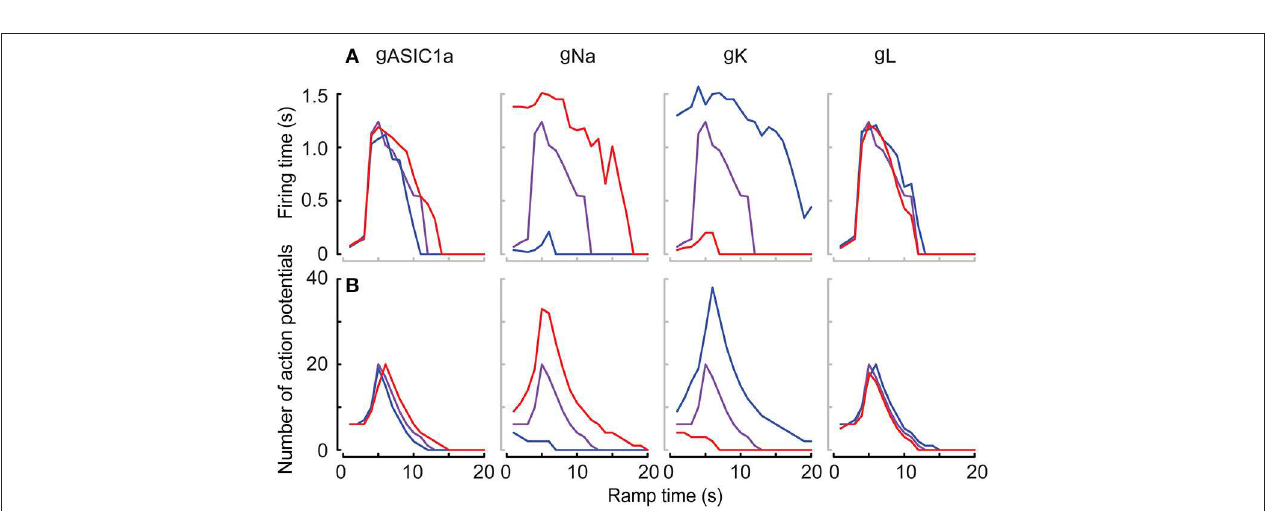
FIGURE 9 | Heat maps of the simulated neuronal activity as a function of the pH ramp lowest value and duration (RT) in seconds, for ramps starting at pH 7.4. Shown are the number of APs (A) and the firing time (s) (B) for the neuronal Hodgkin-Huxley model integrating ASIC1a.